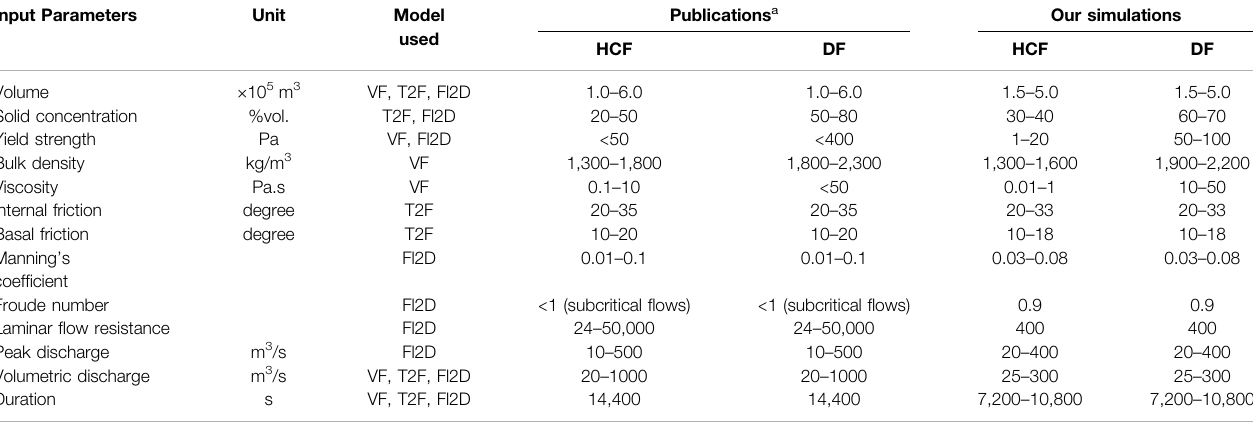
TABLE 7 | Comparison of input parameters used in mass- fl ow numerical simulations (from the literature) compared to our simulations using Titan2F, VolcFlow and FLO-2D codes. Input Parameters